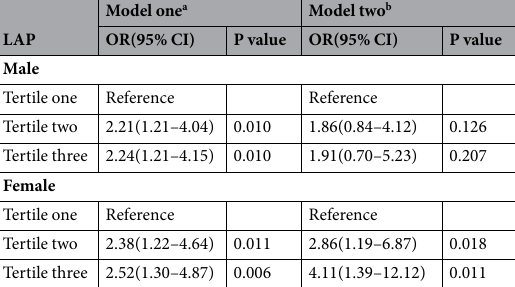
Table 4. Relationship between LAP and ICAS in different genders. a Adjusted for age; b Based on Model one, Model two was further adjusted for diabetes mellitus, hypertension, coronary heart disease, previous stroke, current smoking, daily drinking, body mass index, HDL-C, fasting plasma glucose, waist circumference, systolic blood pressure and diastolic blood pressure. LAP, lipid accumulation product; HDL-C, high density lipoprotein cholesterol; ICAS, intracranial atherosclerotic stenosis.